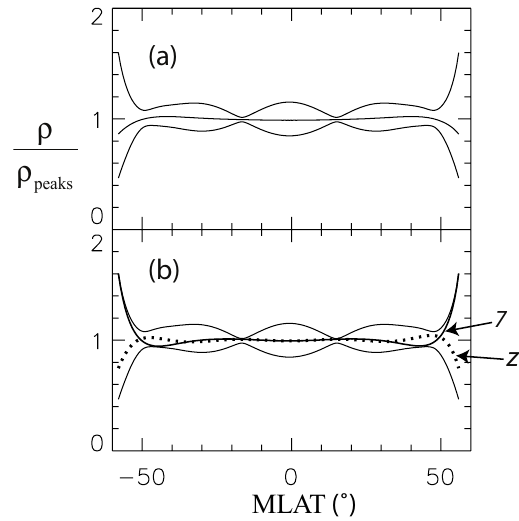
Fig. 6. (a) The (log average) mean mass density ρ (middle curve) and the mean ρ plus or minus one standard deviation (upper and lower curves) at each value of MLAT based on the solutions of ρ from the Monte Carlo simulation using a 5 polynomial fit with re- spect to τ and using the eight Alfv´en wave frequencies observed on 28 October 2002. Here the values of ρ are divided by the mass density found using the peak frequencies in order to better show the difference between the solutions. (b) Same curves for ρ plus or mi- nus one standard deviation (upper and lower curves). The middle solid (dotted) curve is the solution using the peak frequencies but with a 7 polynomial term fit with respect to τ (a 5 polynomial fit with respect to z ). Both of these functions are also divided by the value of ρ found using the peak frequencies using the 5 polynomial fit with respect to τ